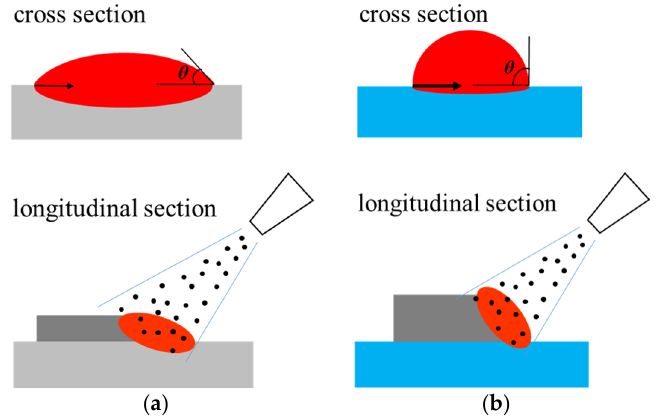
Figure 10. Contact angles and deposit profiles under different cooling conditions. ( a ) natural cooling; ( b ) forced cooling.